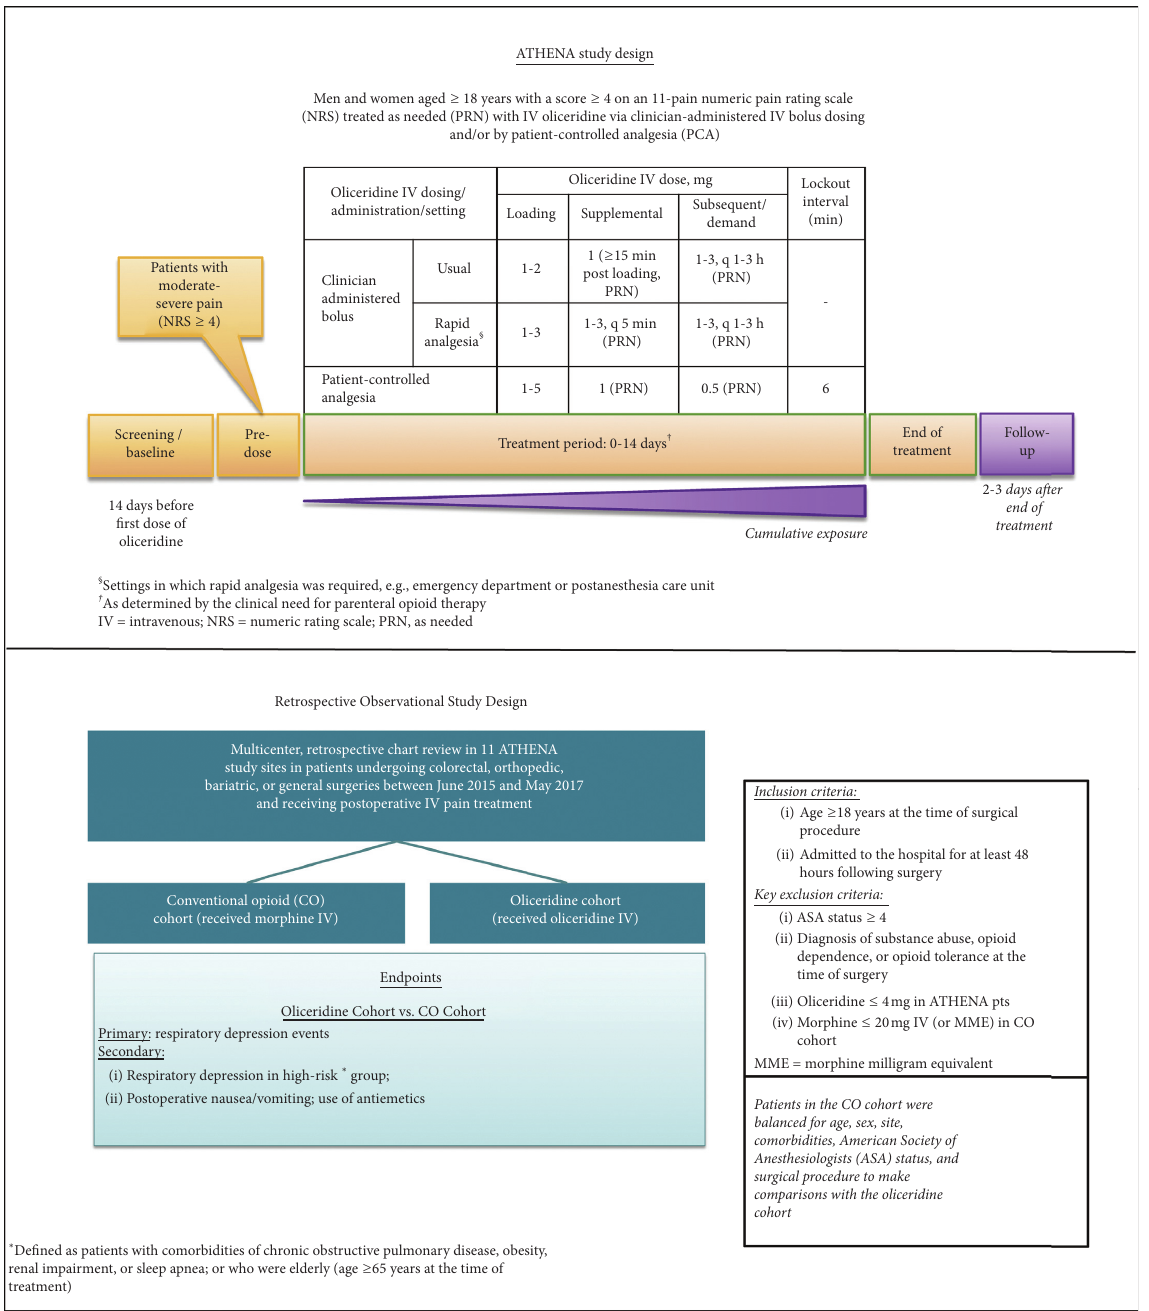
Figure 1: Study design for ATHENA and retrospective observational chart review study. Eleven study sites from the ATHENA trial participated in the retrospective observational chart review study. Subjects in the CO cohort were identified by rigorous chart review during the same interval of time that recruitment for the ATHENA trial had occurred. The CO cohort was limited to individuals treated with IV morphine either alone or in combination with other conventional